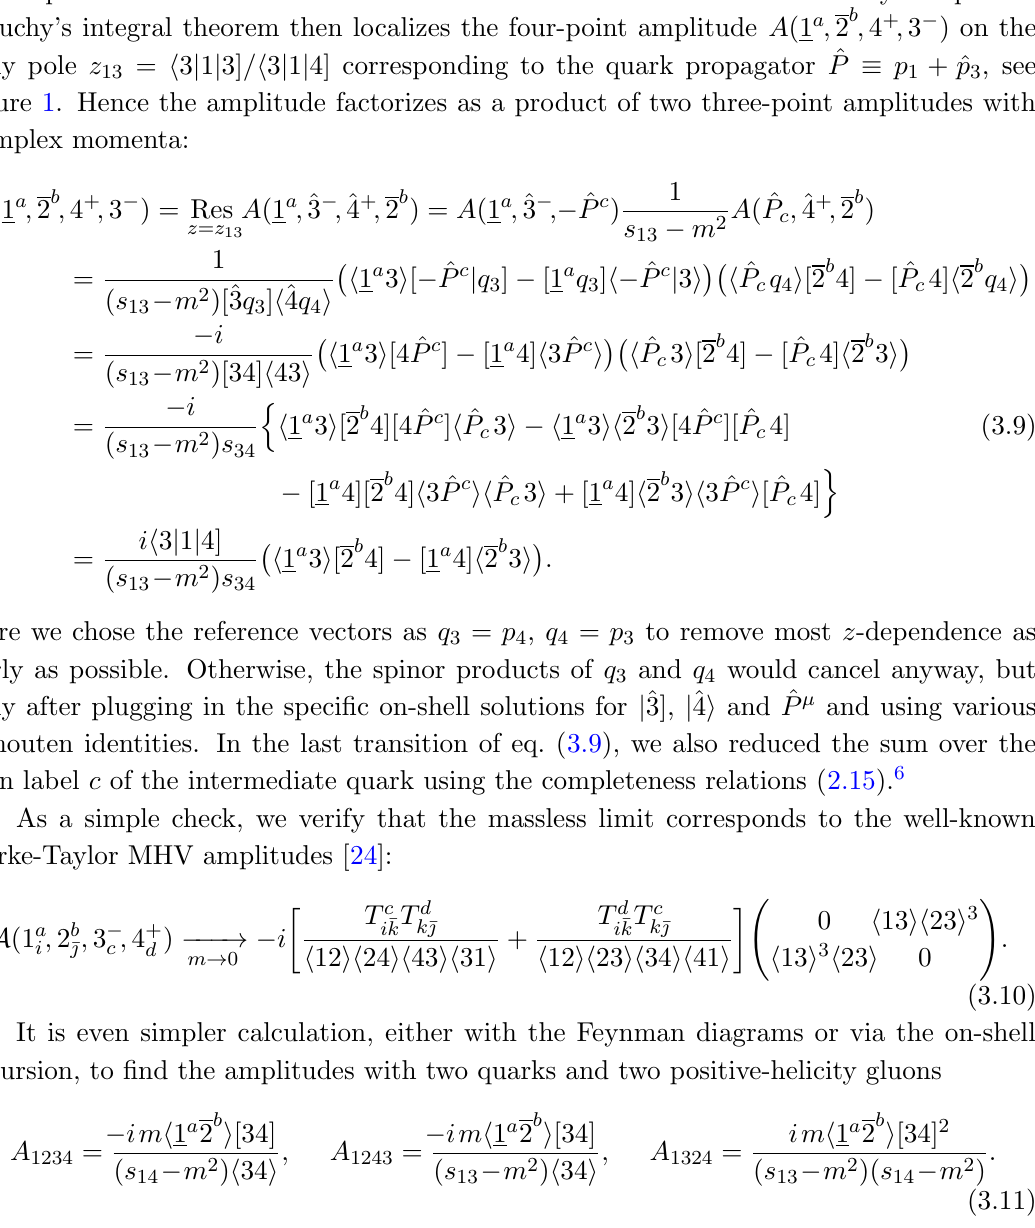
Figure 1 . Graphic representation for the BCFW derivation (3.9) of A (1 a ; ^3 (cid:0) ; ^4 + ; 2 b ). which preserves momentum conservation and the on-shell conditions for any complex z